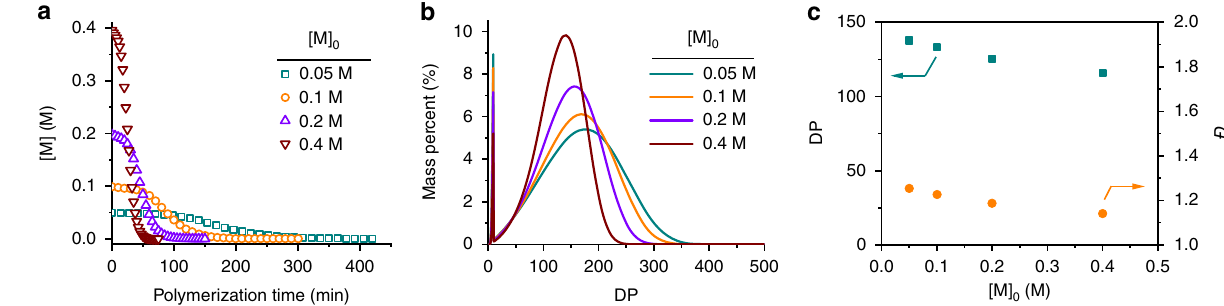
Fig. 4 Simulations with adsorption-incorporated, two-stage kinetic model. a Plot of the monomer concentration vs. time for test cases with s = 10, [M] 0 / [I] 0 = 100, k 1 = 0.02 M − 1 s − 1 , k on = 10 M − 1 s − 1 , k off = 2 s − 1 , k r = 0.2 s − 1 , and at selected values of [M] 0 = 0.05, 0.1, 0.2, or 0.4 M. b Predicted MWD pro fi les based on the kinetic pro fi les in a . c Calculated DP and Đ at various [M] 0 . NATURE COMMUNICATIONS| (2019) 10:5470